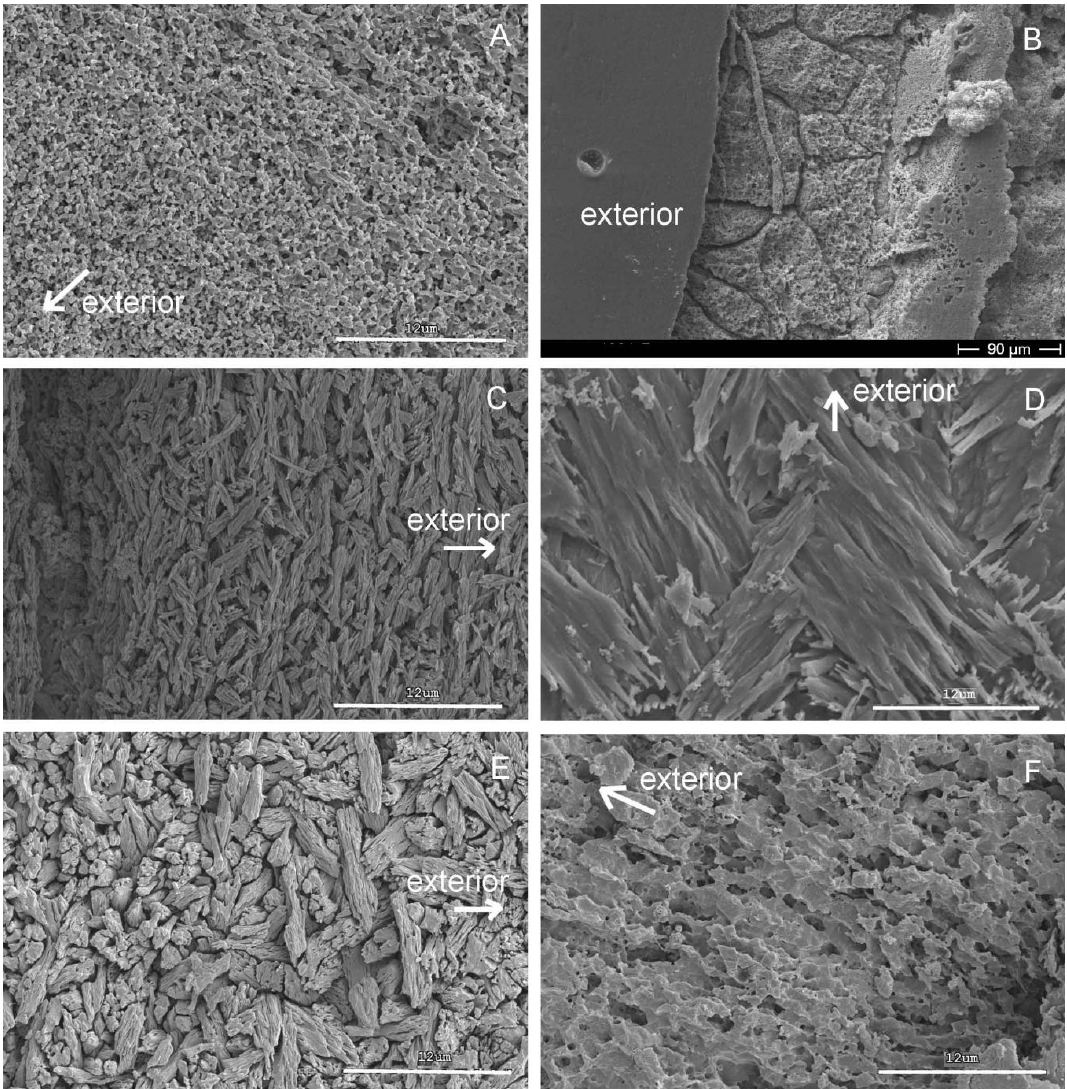
Figure 1. ( A ) Hydroides elegans from the Miocene of Austria, longitudinal section of external tube layer with a fine homogeneous granular structure. ( B ) Longitudinal section of coarse angular crystal homogeneous microstructure in Filogranula tricristata from the Bajocian of Switzerland. ( C ) Longitudinal section of irregularly oriented prismatic structure (IOP) in Protula canavarii (Miocene, Austria). ( D ) Transverse section of the irregularly oriented platy (IOPL) in Neovermilia falcigera from the Pleistocene of Italy. ( E ) Longitudinal section of semi-ordered IOP structure in Protula protensa (Upper Eocene). ( F ) Transverse section of simple prismatic structure in Placostegus polymorphus from the Miocene of Austria (arrow indicates orientation of prisms).